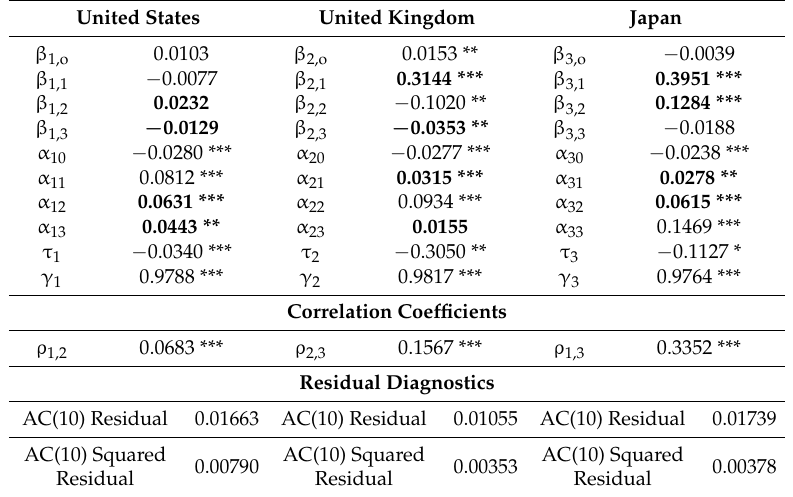
Table A4. Estimation from the multivariate MVR-EGARCH model (Islamic equities—pre-crisis). United States